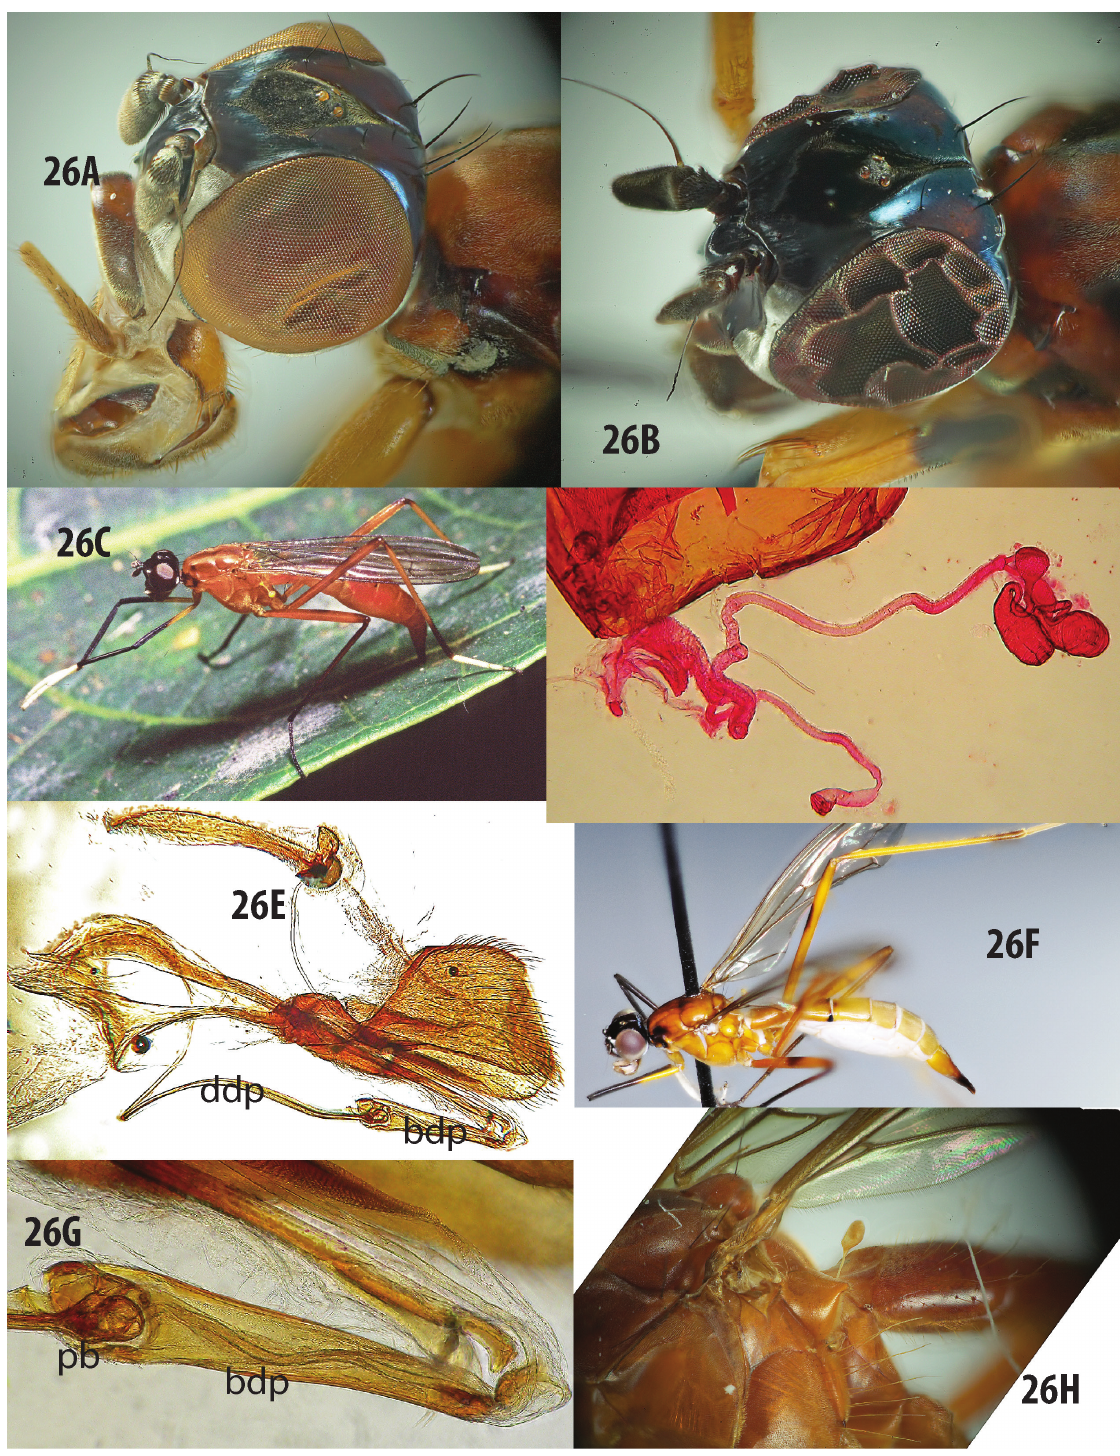
Fig. 26. Mesoconius nigricephala sp. nov . A . Head, ♀ from Colombia. B . Head, specimen from Ecuador (postocellar bristles missing). C . Paratype prior to capture, ♀, Ecuador (inner vertical and postocellar bristles visible). D . Spermatheca and associated structures, specimen from Colombia. E . Male terminalia, lateral view, specimen from Colombia. F . ♀, specimen from Colombia. G . Basal part of phallus. H . Thorax and base of abdomen, ♀, showing prominent katatergite. Abbreviations: bdp = basal distiphallus; ddp = distal distiphallus; pb = phallic